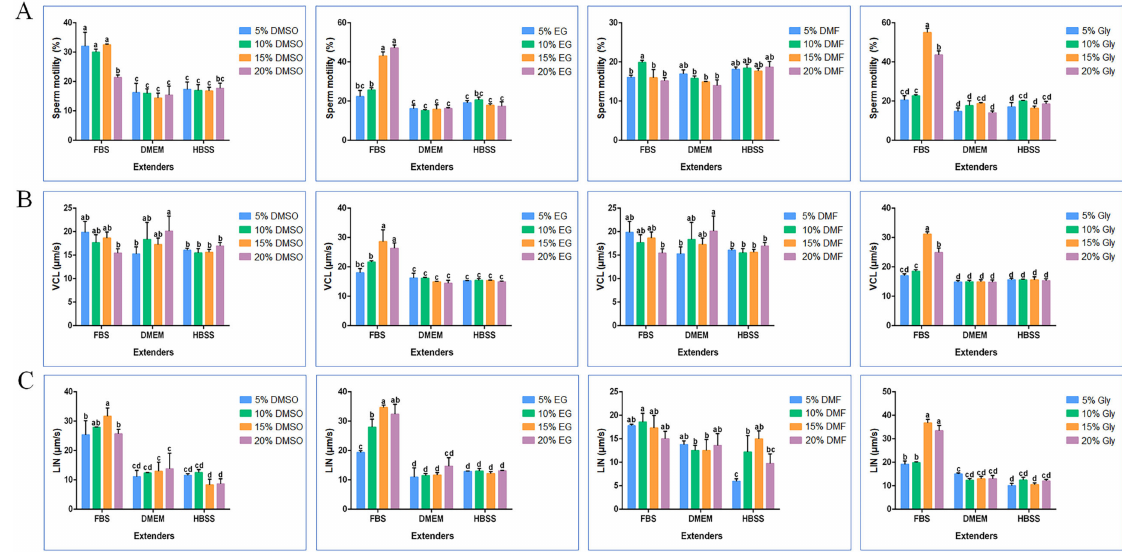
Figure 1. Effects of different cryodiluents on the post-thaw sperm motility parameters. ( A ) The motility of post-thaw sperm, ( B ) the VCL of post-thaw sperm, ( C ) the LIN of post-thaw sperm. VCL, curvilinear velocity; LIN (linearity, LIN = straight line velocity (VSL, µ m/s) × VCL-1 × 100%). Statistical significance was accepted when p < 0.05 and indicated by different letters. FBS, fetal bovine serum; HBSS, Hank’s balanced salt solution; DMEM, Dulbecco’s modified eagle medium; DMSO, dimethyl sulfoxide; EG, ethylene glycol; DMF, N , N -dimethylformamide; Gly,